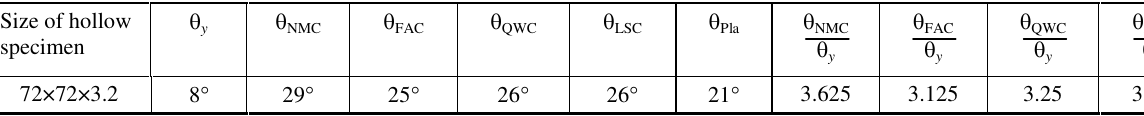
Table 6. Results of beam specimens Beam